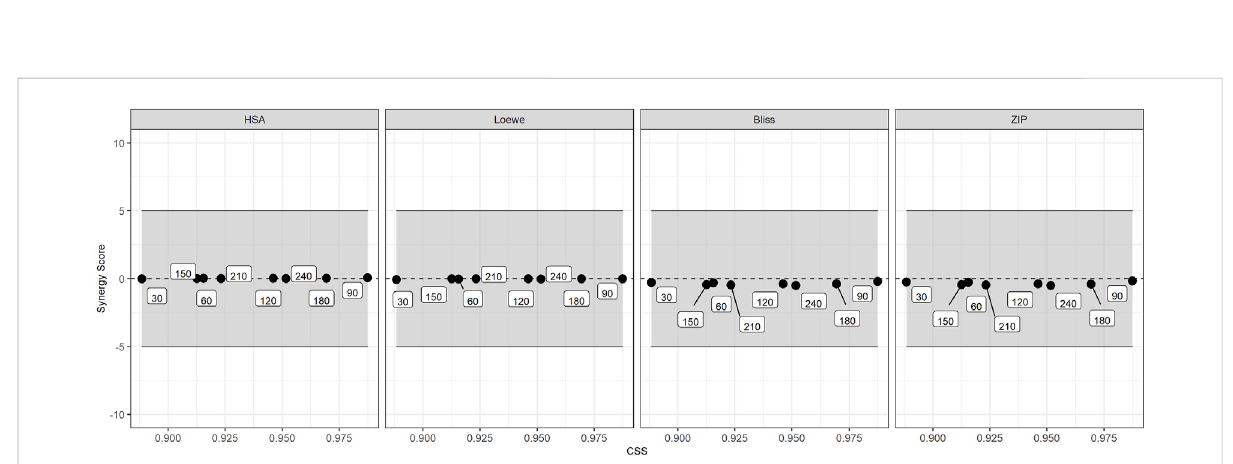
FIGURE 6 Synergy Scores (SS) and the overall Combination Sensitivity Score (CSS) for the combination EPM/IVM matrix . Each panel represents a different reference model of Synergy Scoring models with different assumptions regarding the expected effect (HSA = Highest Single Agent; BLISS = Bliss Independence; LOEWE = Loewe model and ZIP = Zero Interaction Potency). The gray zone indicates additive effect (Malyutina et al., 2019). Squares indicate the different